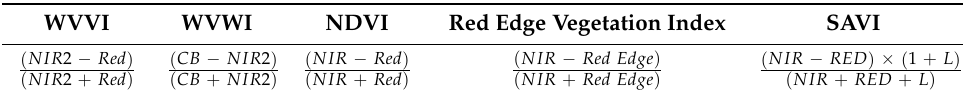
Table 1. Vegetation Indices, including Worldview-2 Vegetation Index, Worldview-2 Water Index, Red Edge Vegetation Index, Normalized Difference Vegetation Index and Soil Adjusted Vegetation Index. WVVI WVWI NDVI Red Edge Vegetation Index